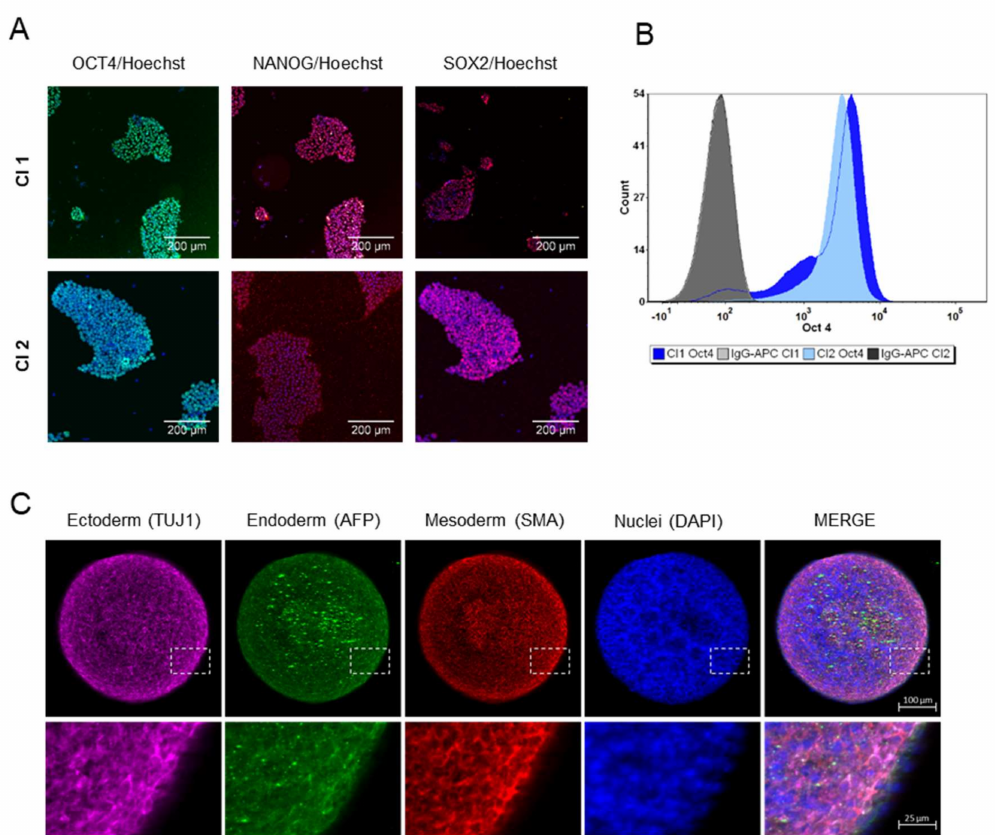
Figure 1. Characterization of human iPSCs. ( A ) Immunofluorescence staining demonstrates the expression of the pluripotent transcription factors OCT4, NANOG, and SOX2 in growing iPSCs (Cl1 and Cl2). Scale bar represented 200 µ m. ( B ) Representative flow cytometry analysis of OCT4 positive cells in iPSCs (Cl1-92% and Cl2-98%) during routine culture. ( C ) Expression of germ layer markers in seven-day EBs (Cl1): representative immunofluorescence staining showing the expression of ectoderm germ-layer in pink (TUJ1), endoderm germ layer in green (AFP), mesoderm germ-layer in red (SMA) and nuclei in blue (DAPI), in the single images as well as in the merge view. Magnifications (4 × ) of the delineated insert are reported. Scale bar represented 100 µ